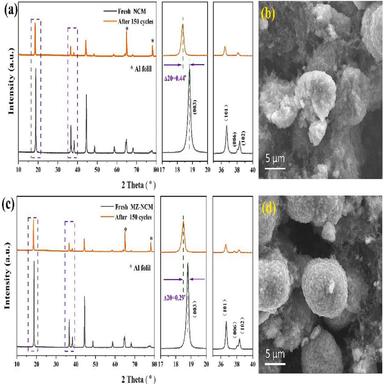
XRD patterns and SEM images of NCM (a, b) and MZ-NCM (c, d) after 150 cycles at 1C in range of 2.8 V to 4.3 V.